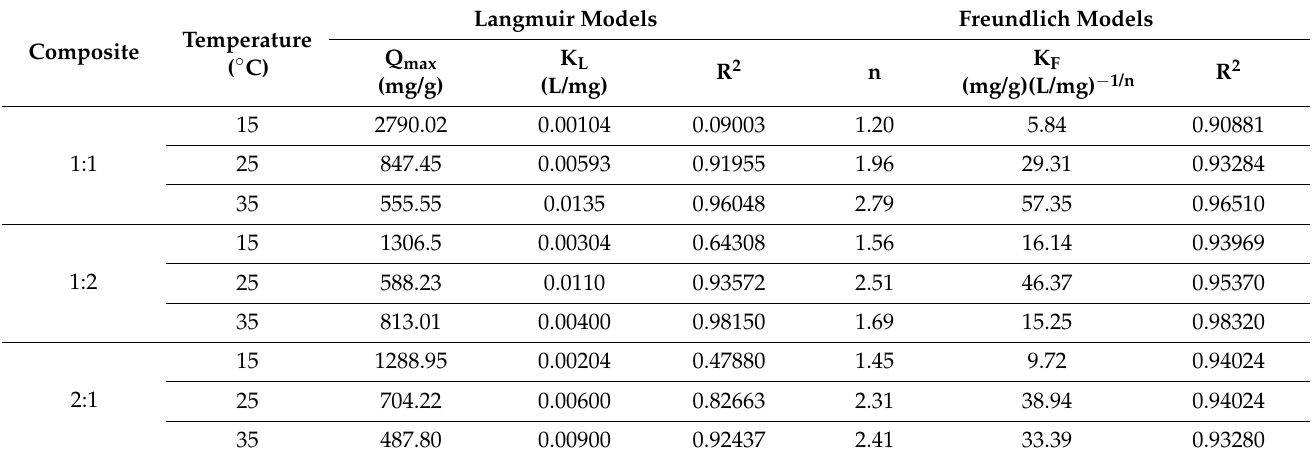
Table 2. Adsorption isotherm constants for Cu(II) adsorption by PNMBC at different temperatures.